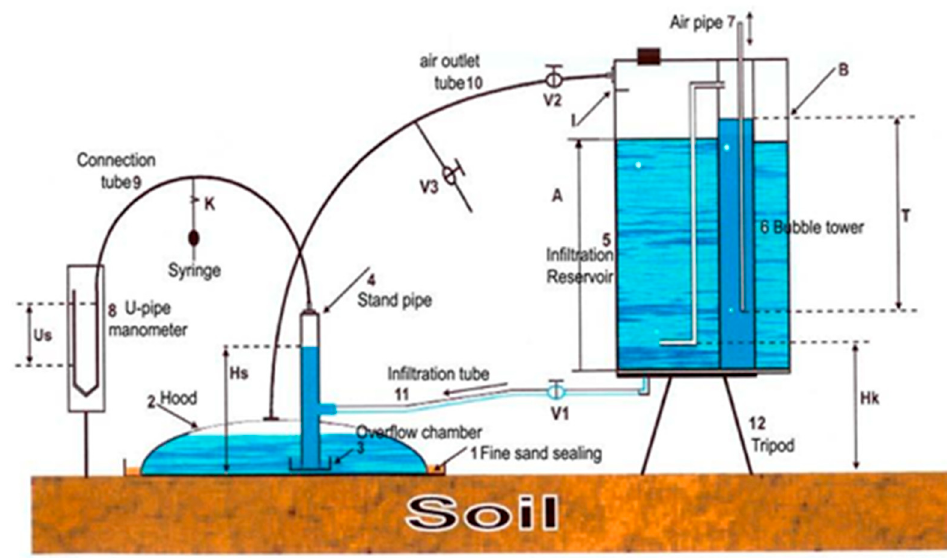
Figure 2. Principles of infiltration measurement using a Hood infiltrometer [20].